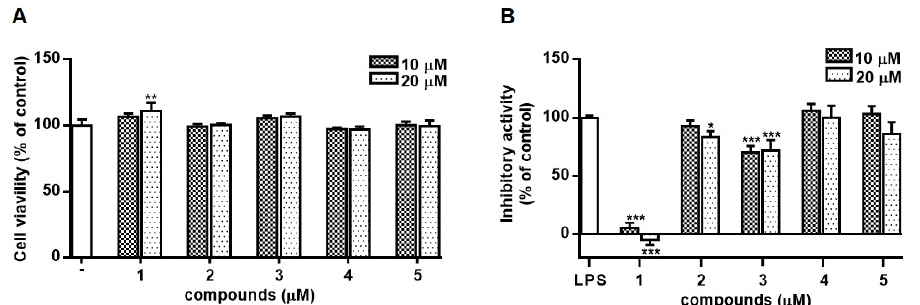
Figure 3. Effects of compounds 1 – 5 isolated from S. brachyotus on cell viability ( A ) and NO produc- tion ( B ) in RAW264.7 cells. RAW264.7 cells were incubated with each compound at the concentra- tions of 10 or 20 µM for 24 h. Cell viability was measured using the MTT assay. The concentration of nitrite in the culture medium was measured by Griess reaction, and sodium nitrite was used as a standard. Results are presented as the mean ± standard deviation from three independent experi- ments. The results of cell viability ( A ) differ significantly from non-treated control cells, and the results of NO production ( B ) differ significantly from LPS-only treated cells; * p < 0.05, ** p < 0.01 and *** p < 0.001.